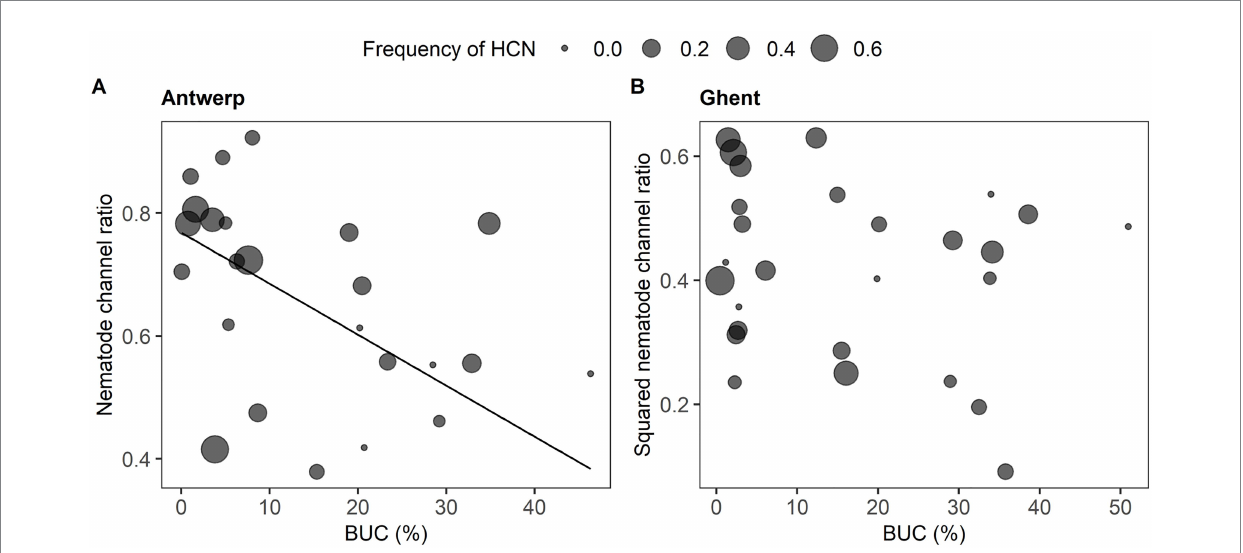
FIGURE 3 Linear relationship of nematode channel ratio with urbanization (BUC) within a 200-meter radius in the cities of Antwerp (A) and Ghent (B) . The effects of predictors are presented in Supplementary Table S3. Nematode channel ratio is plotted against BUC values and the size of dots corresponds to the proportion of HCN-producing plants. The fitted line for the significant predictor of BUC at p < 0.05 is based on its modeled intercept and